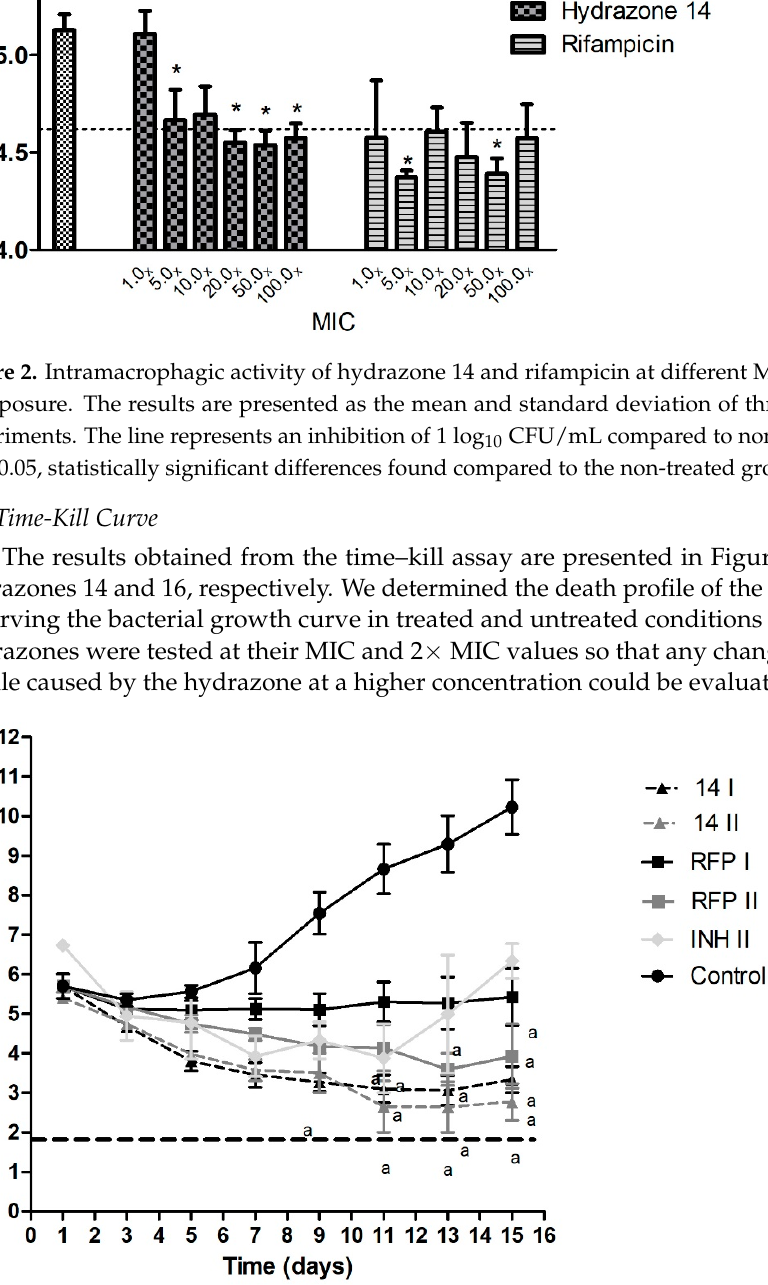
Figure 2. Intramacrophagic activity of hydrazone 14 and rifampicin at different MICs after 3 days of exposure. The results are presented as the mean and standard deviation of three independent experiments. The line represents an inhibition of 1 log 10 CFU/mL compared to non-treated control. * p < 0.05, statistically significant differences found compared to the non-treated group.